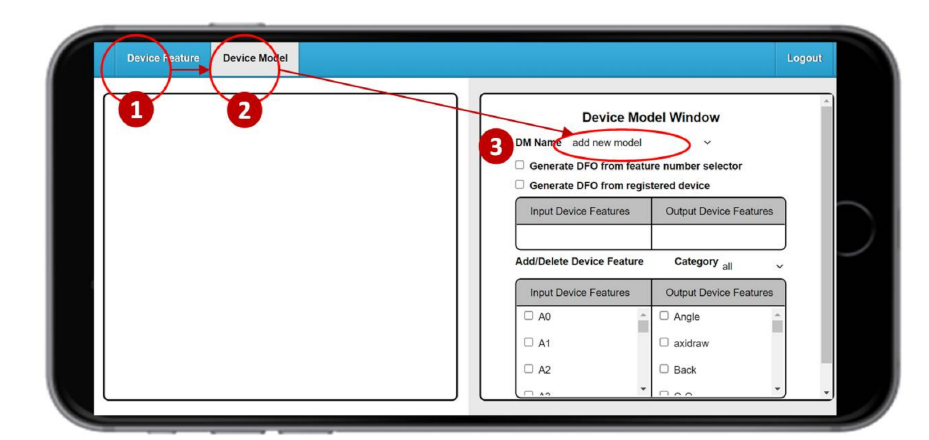
Figure 4. The Device Model (DM) window.